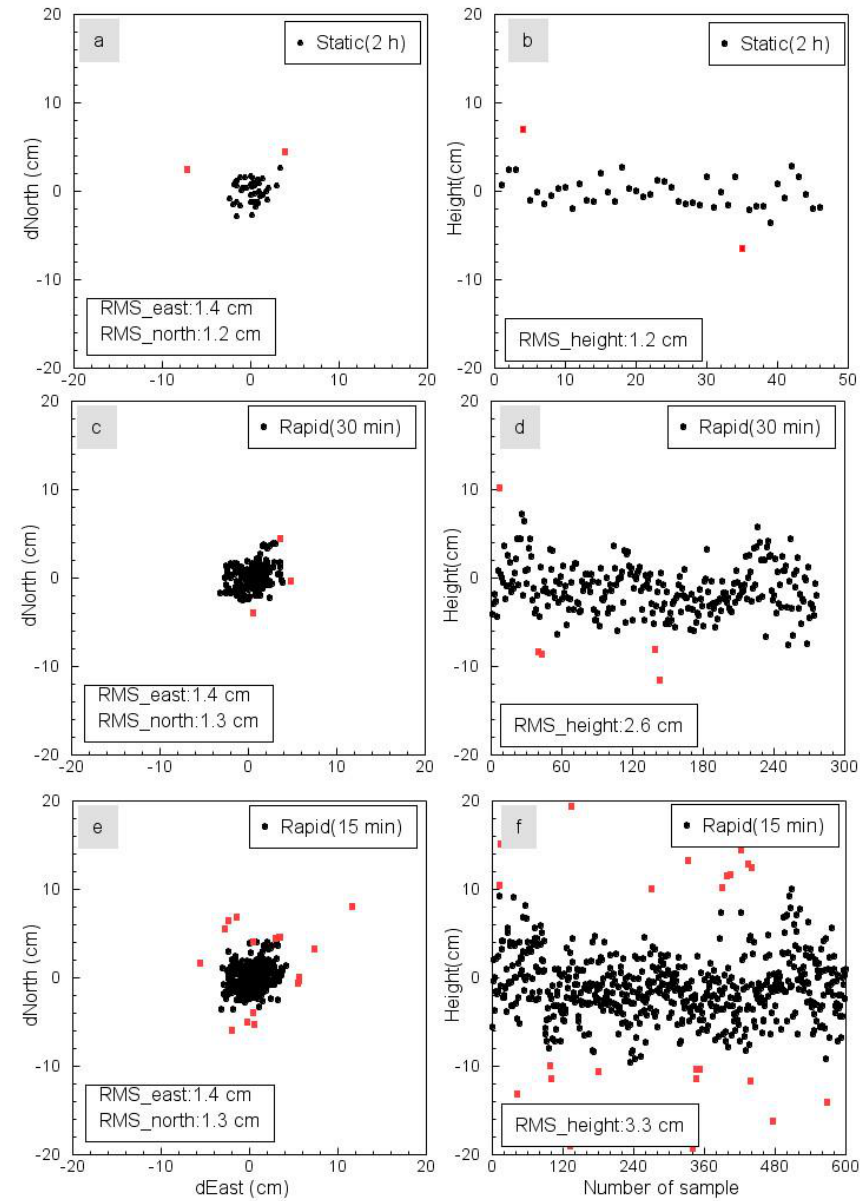
Figure 8. Plots illustrating the performance of the Online Positioning User Service for Static (OPUS-S) processing and Rapid-Static (OPUS-RS) processing in Freeport, Texas. ( a ) Horizontal trajectory of OPUS-S solutions for 46 2-h static GPS surveys at the benchmark (Figure 7); ( b ) heights of OPUS-S solutions for these 46 2-h static surveys; ( c ) and ( d ): horizontal and vertical solutions of OPUS-RS solutions for 276 30-min static GPS surveys at the benchmark; ( e ) and ( f ): horizontal and vertical solutions of OPUS-RS solutions for 618 15-min static GPS surveys at the benchmark. Red dots represent outliers that are not included in calculating the RMS of errors. The repeated GPS campaign surveys at the benchmark were conducted over six years, from 2013 to 2018. Table 2. Statistics of OPUS solutions for campaign surveys at the benchmark.